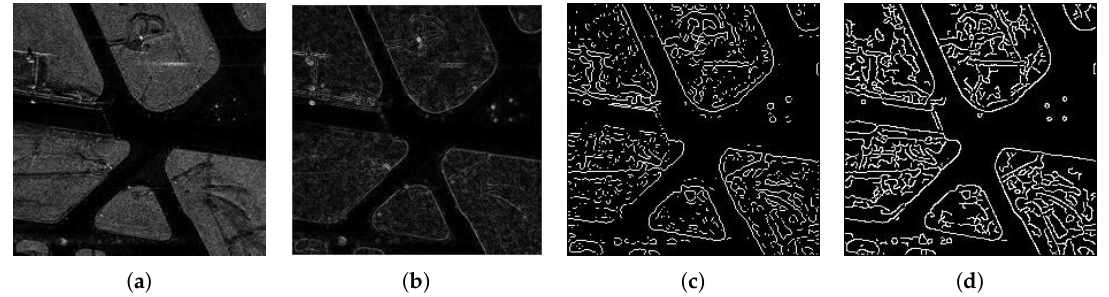
Figure 1. The edge detection results of synthetic aperture radar (SAR) image1. ( a ) Original image; ( b ) first-order result; ( c ) Gaussian–Laplacian operator result; ( d ) Canny operator result.